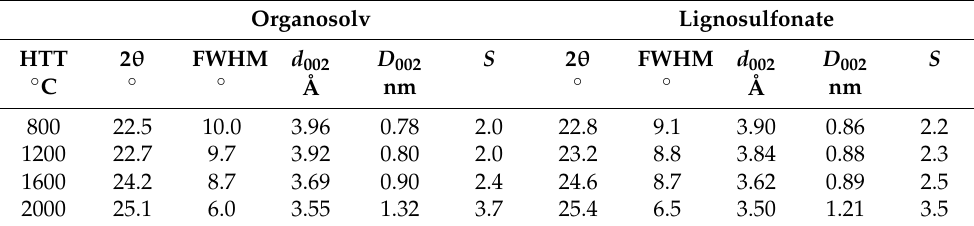
Table 1. Apparent crystallite size D 002 and lattice spacing d 002 evaluated from the FWHM and the peak position 2 θ of the (002)-peak, respectively. The corresponding heat treatment temperature (HTT) and the resulting number of graphite layers S is indicated. The errors from the fit are < 0.5% for the peak position and <4% for the FWHM, resulting in an error estimate of maximum ± 0.02 in d 002 , of maximum ± 0.04 in D 002 and of about ± 0.1 in S .